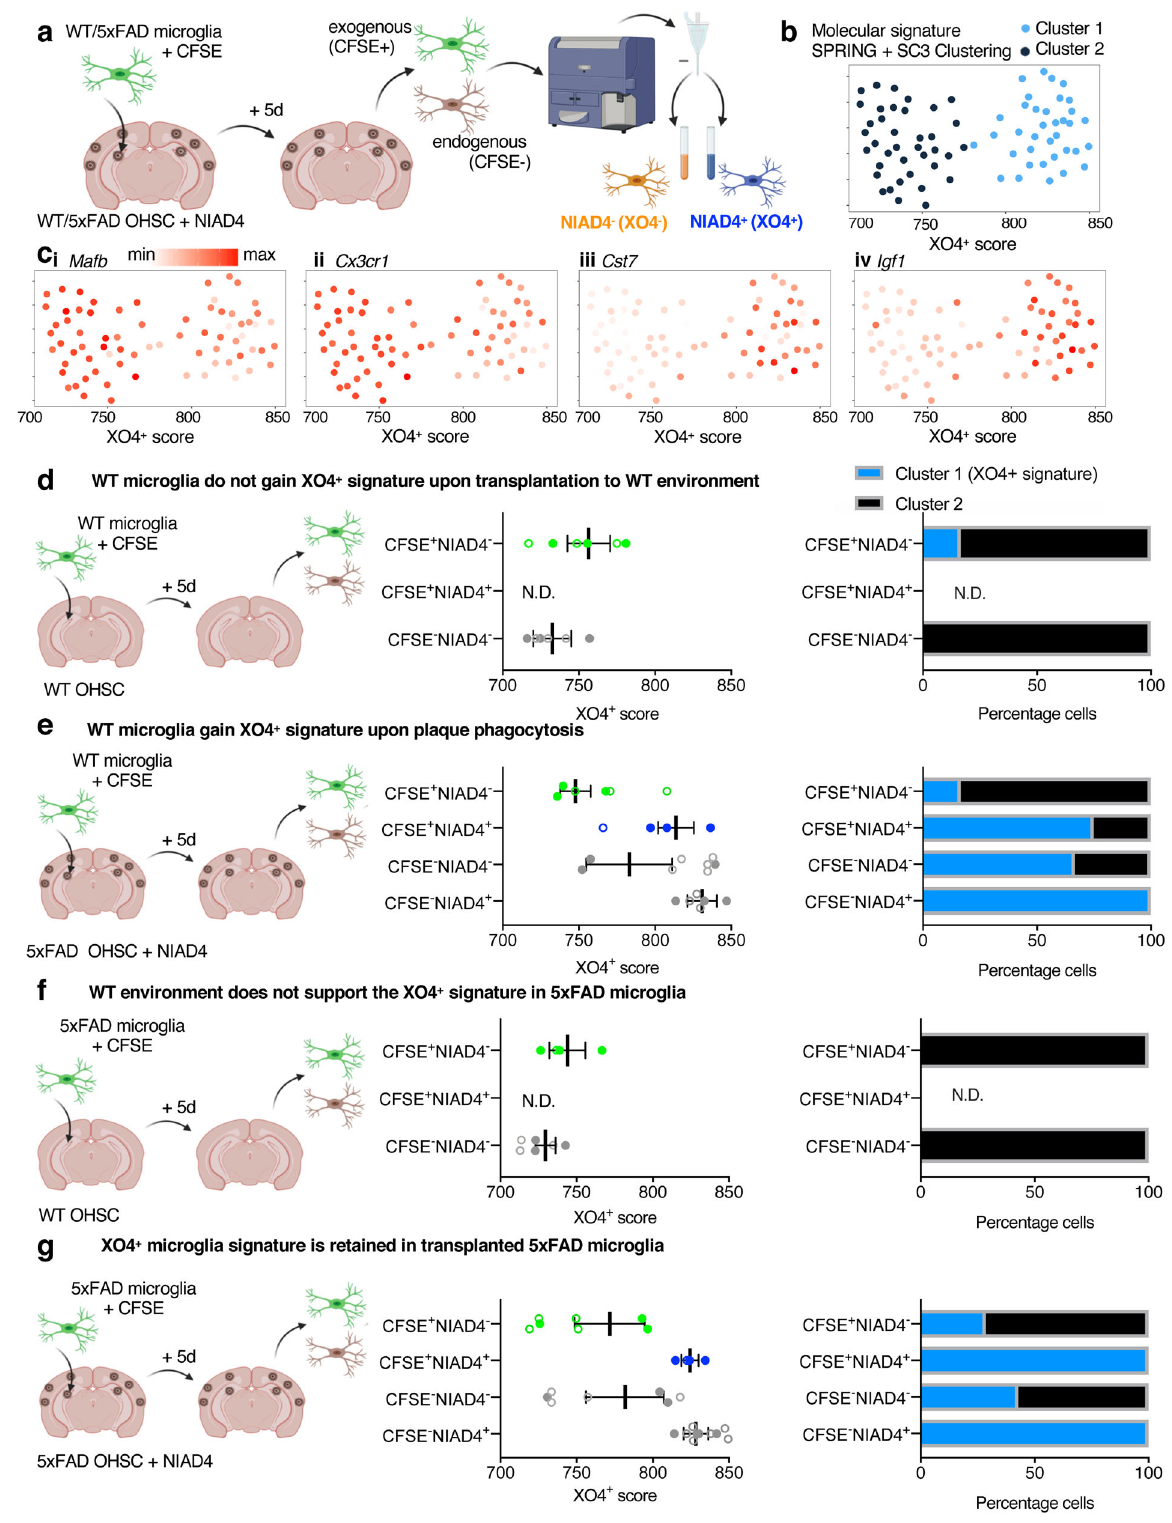
and (2) plaque-associated microglial signatures can be detected using our system, we also cultured (1) WT microglia with WT OHSCs and (2) 5xFAD microglia with 5xFAD OHSCs, respec- tively. Using FACS, we sorted groups of 10 endogenous (CSFE − ) and exogenous (CFSE + ) microglial cells that were plaque-positive (NIAD4 + ) or -negative (NIAD4 − ) for molecular pro fi ling (Sup- plementary Fig. 9a). QPCR analysis followed by SC3 clustering